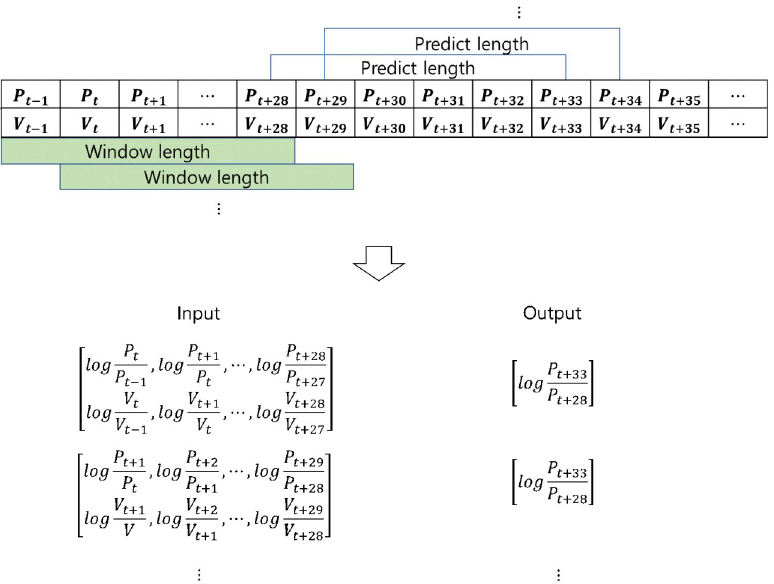
Fig 5. Preprocessing stock time series data using logarithmic return based on the window length and predict length.